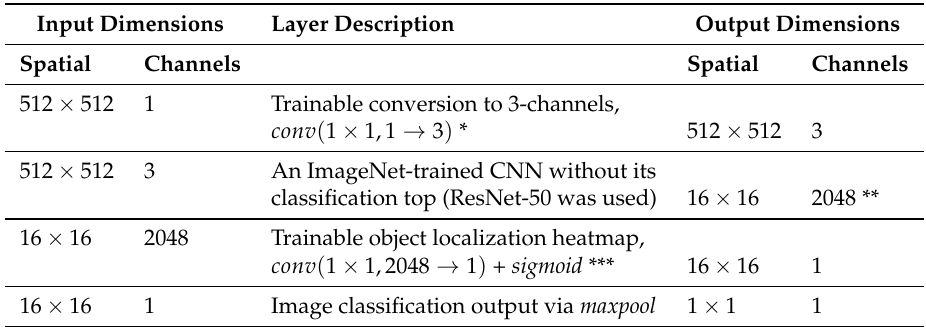
Table 1. MWD Convolutional Neural Network (CNN) architecture yielding simultaneous approximate whale localization and image